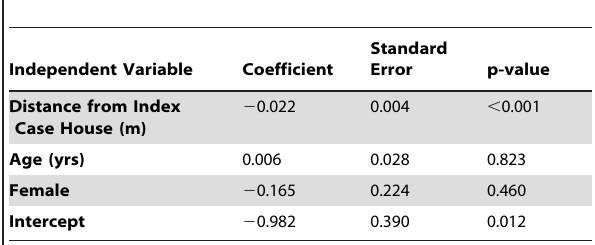
Table 1. Mixed-effects logistic regression analysis of the probability of DENV infections in child contacts in positive clusters.